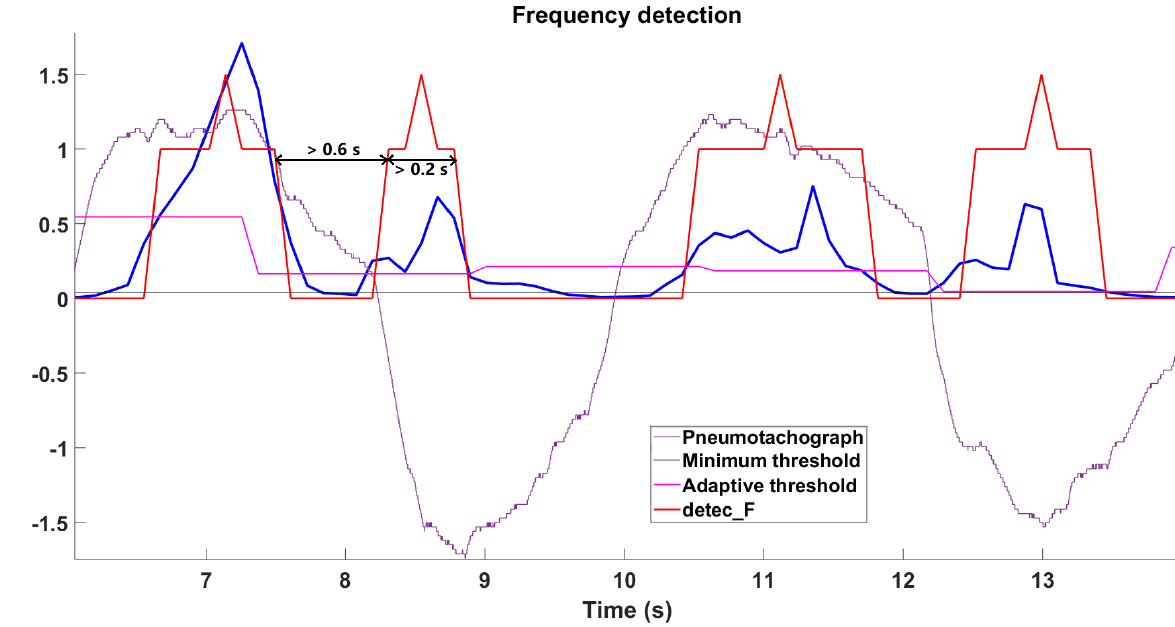
Figure 6. Temporal and frequency detection result of the same period from the same recording. A positive (resp. negative) pneumotachograph reference signal (purple) indicates inspiration (resp. expiration). The adaptive (pink) and minimum thresholds (gray) are marked in the figure. The envelope signal (temporal or PSD) is in blue, and the final detection result is in red with the peak “middle-timing